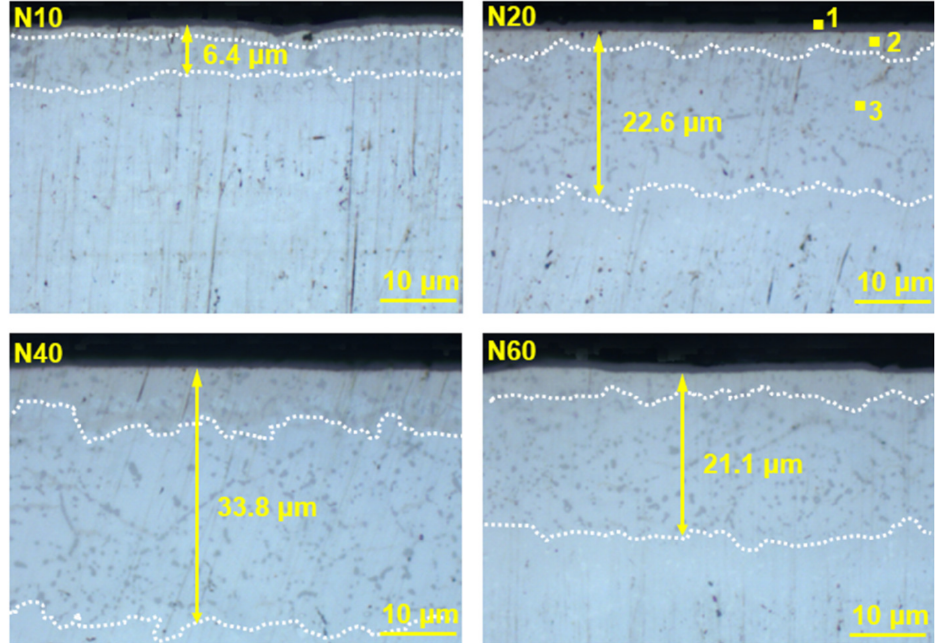
Figure 3. Optical images of the cross-section microstructure of the samples after the duplex treatment: 1—CrAlN coating; 2—compound layer (CL); 3—nitrogen diffusion zone (DZ). The averaged total thickness of the CL and DZ is added